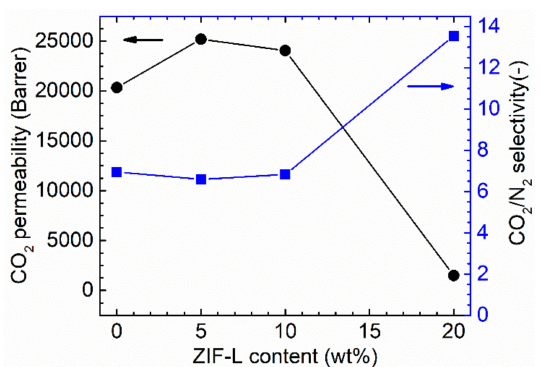
Figure 10. Gas separation performances of PTMSP/ZIF-L hybrid membranes as a function of the ZIF-L loading.